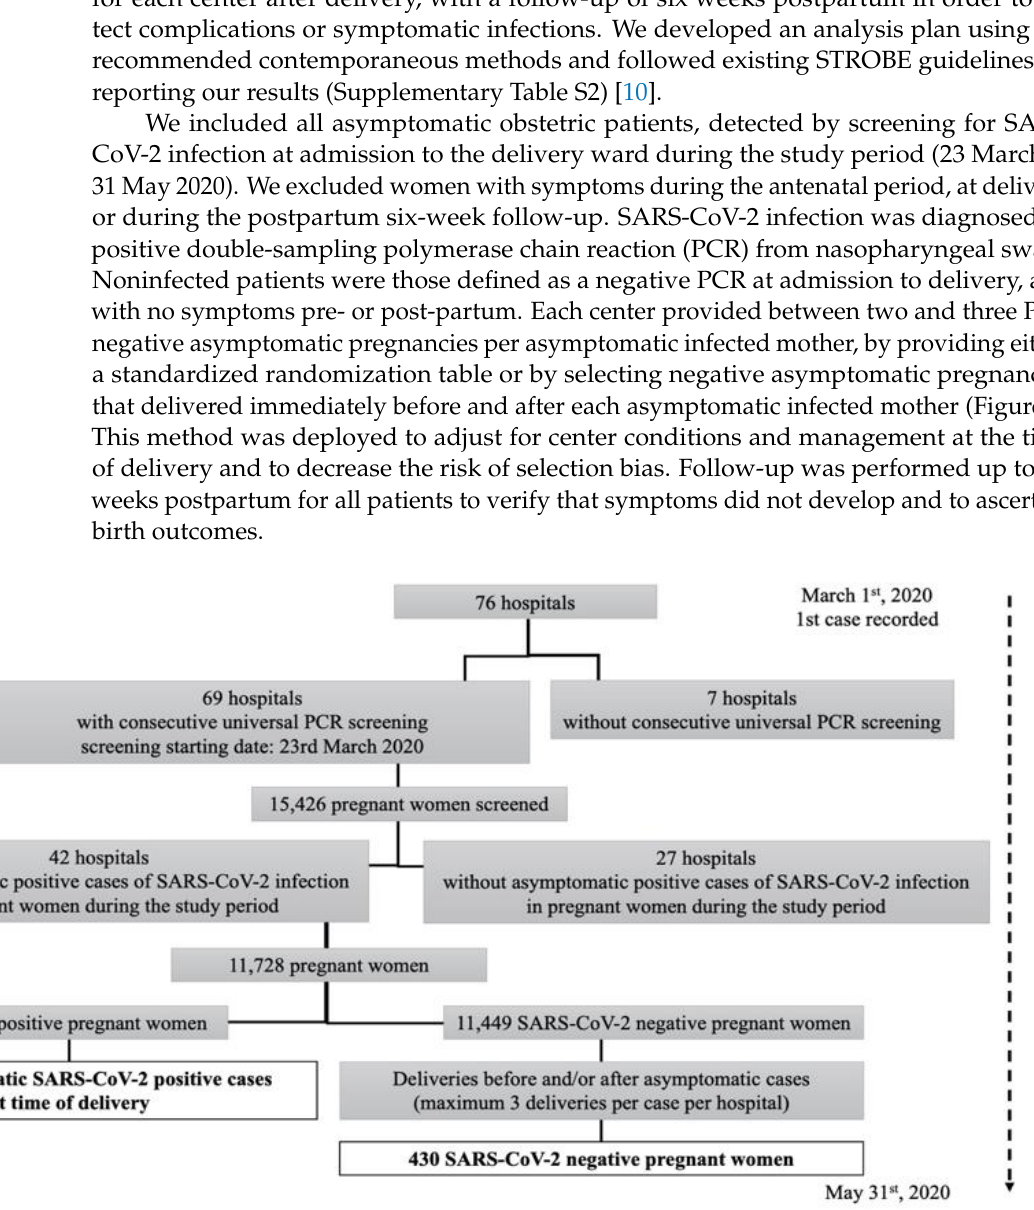
Figure 1. Flow chart of the study data. PCR, polymerase chain reaction; SARS-CoV-2, severe acute respiratory syndrome coronavirus 2.